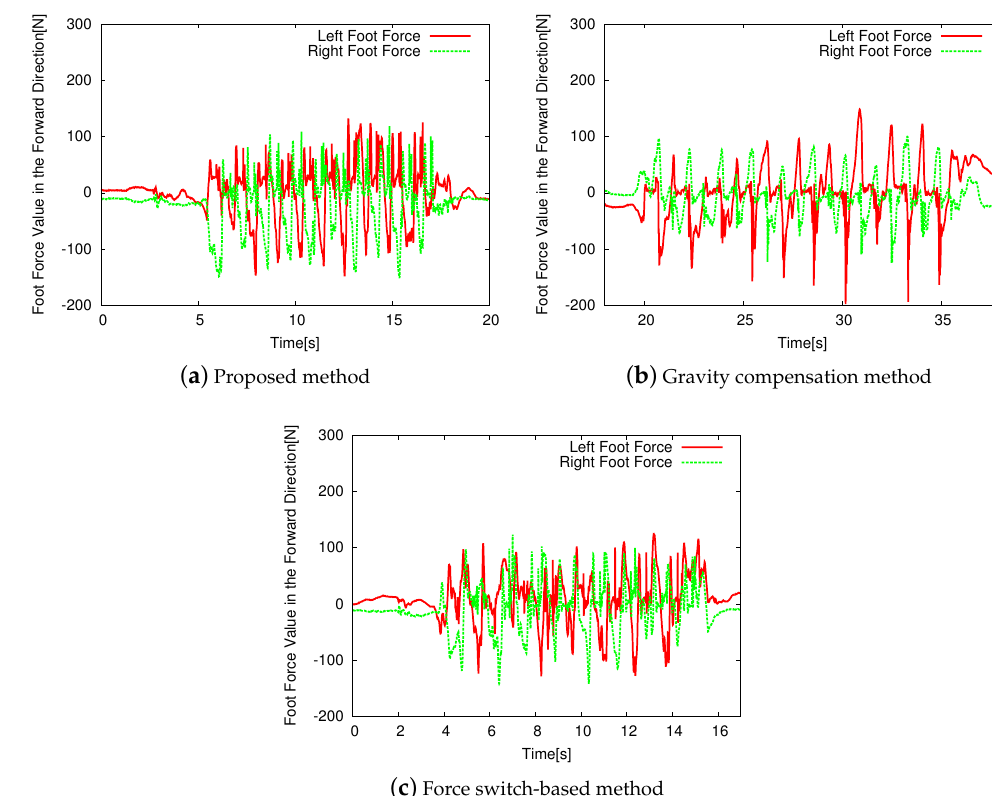
Figure 11. Reaction force on feet in horizontal front-back direction while walking forward based on each control